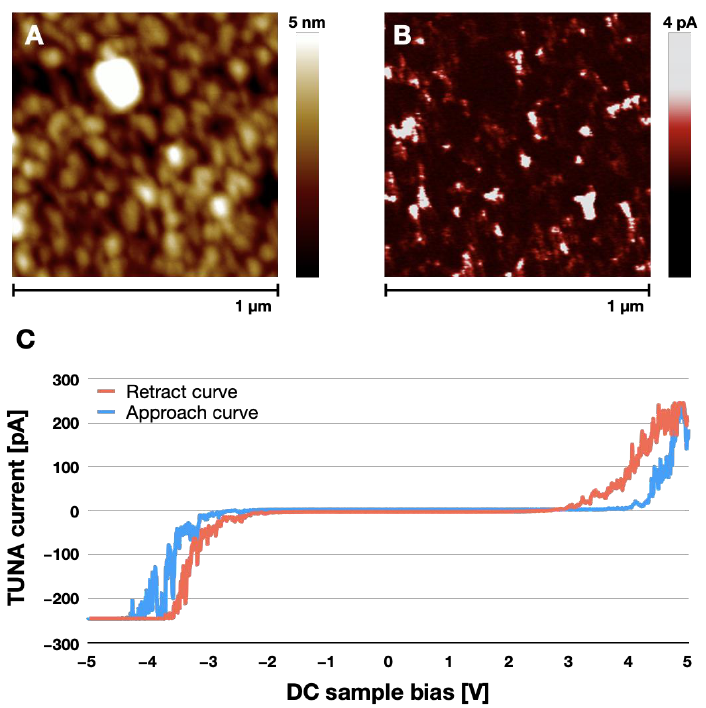
Figure 3. AFM images visualizing: ( A ) topography, ( B ) conductivity of polymer brushes obtained via Sonogashira coupling on the ITO substrate, ( C ) a representative I/V curve.